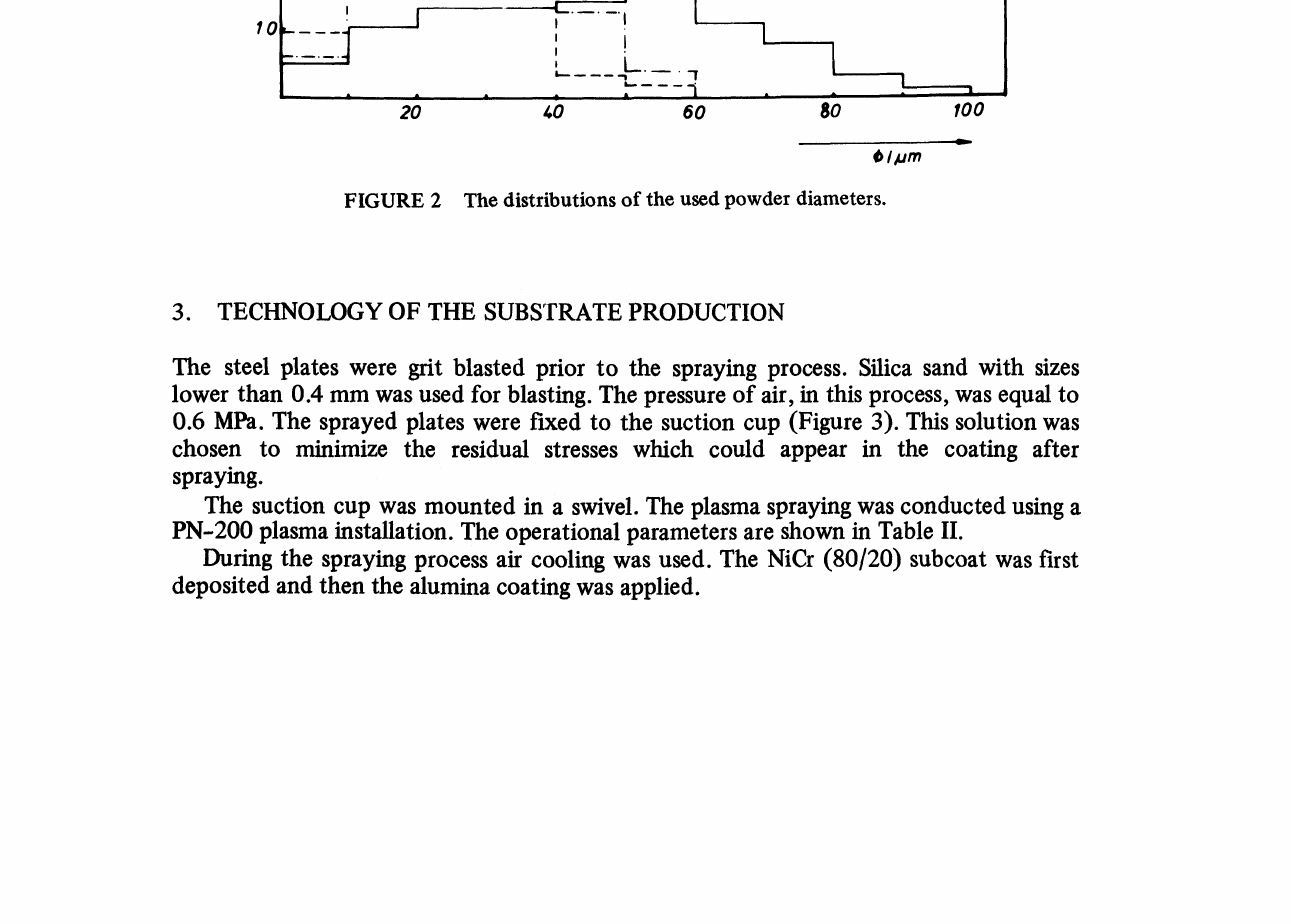
FIGURE 2 The distributions of the used powder